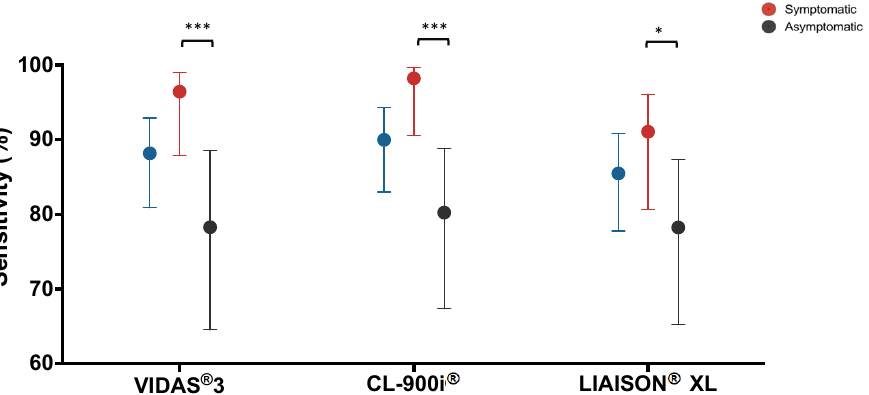
Figure 1. Sensitivity of each assay in samples collected ≥ 21 days post symptom onset using RT-PCR as a reference test. Data are presented for 111 RT-PCR confirmed SARS-CoV-2 samples categorized into: symptomatic ( n = 56); asymptomatic ( n = 51); and unclassified ( n = 4); run on each automated assay; VIDAS ® 3, CL-900i ® , LIAISON ® XL. Chi-square test was used to detect the presence of a statistically significant difference in the sensitivity of each assay between the symptomatic and asymptomatic samples. * p < 0.05, *** p < 0.0001.